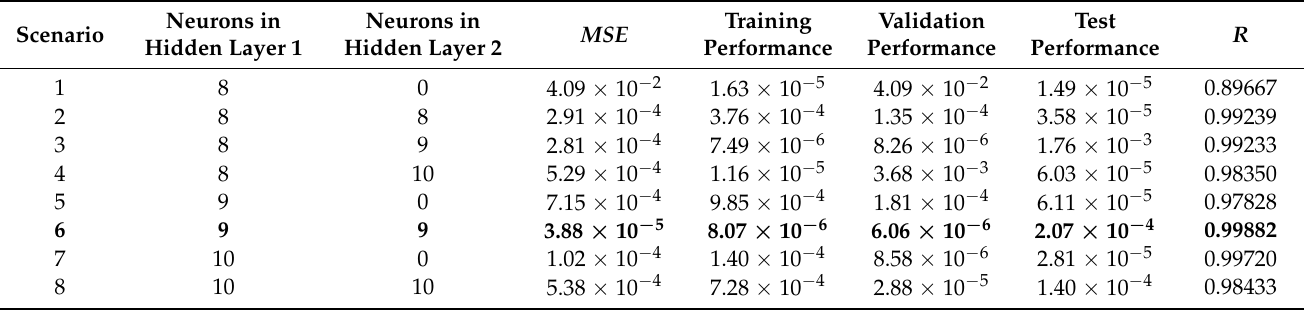
Table 4. ANN architectures and their performance for a network with four